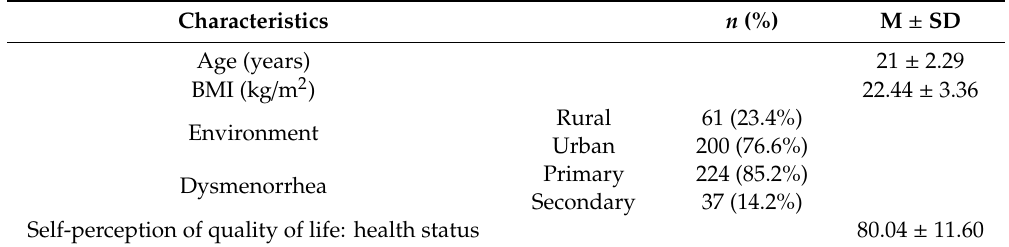
Table 1. Socio-demographic, gynecological and quality of life